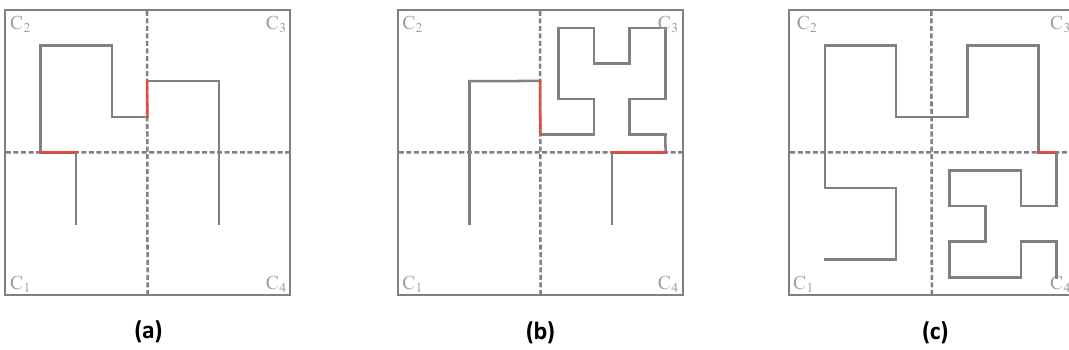
Figure 2. Three different kinds of Hilbert curves with heterogeneous orders: ( a ) 1-order curve in C 1 , C 3 , C 4 and 2-order curve in C 2 ; ( b ) 1-order in C 1 , C 2 , C 4 and 3-order curve in C 3 ; ( c ) 2-order curve in C 1 , C 2 , C 3 and 3-order in C 4 .